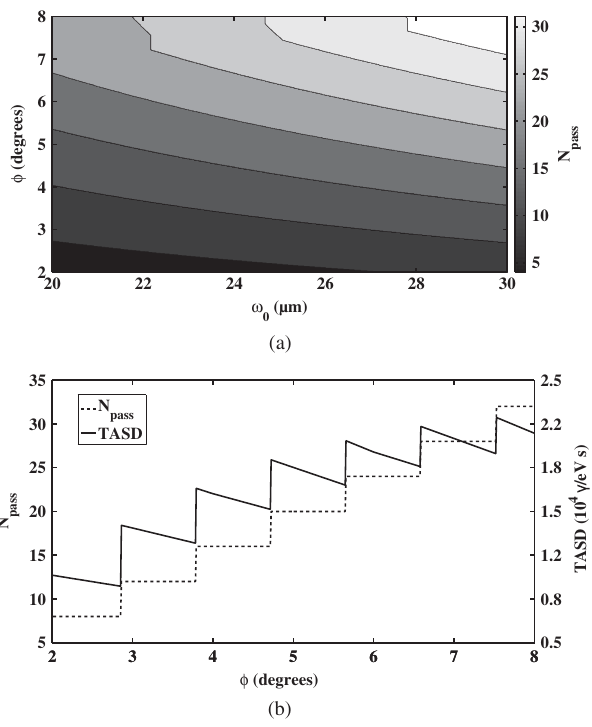
FIG. 7. (a) The maximum number of passes as a function of ϕ and w 0 . The region of interest is the light gray region. (b) The TASD and maximum number of passes as a function of ϕ for w 28 . 3 μ m. The results correspond to the 10 MeV γ -ray beam 0 ¼ (see Table I).